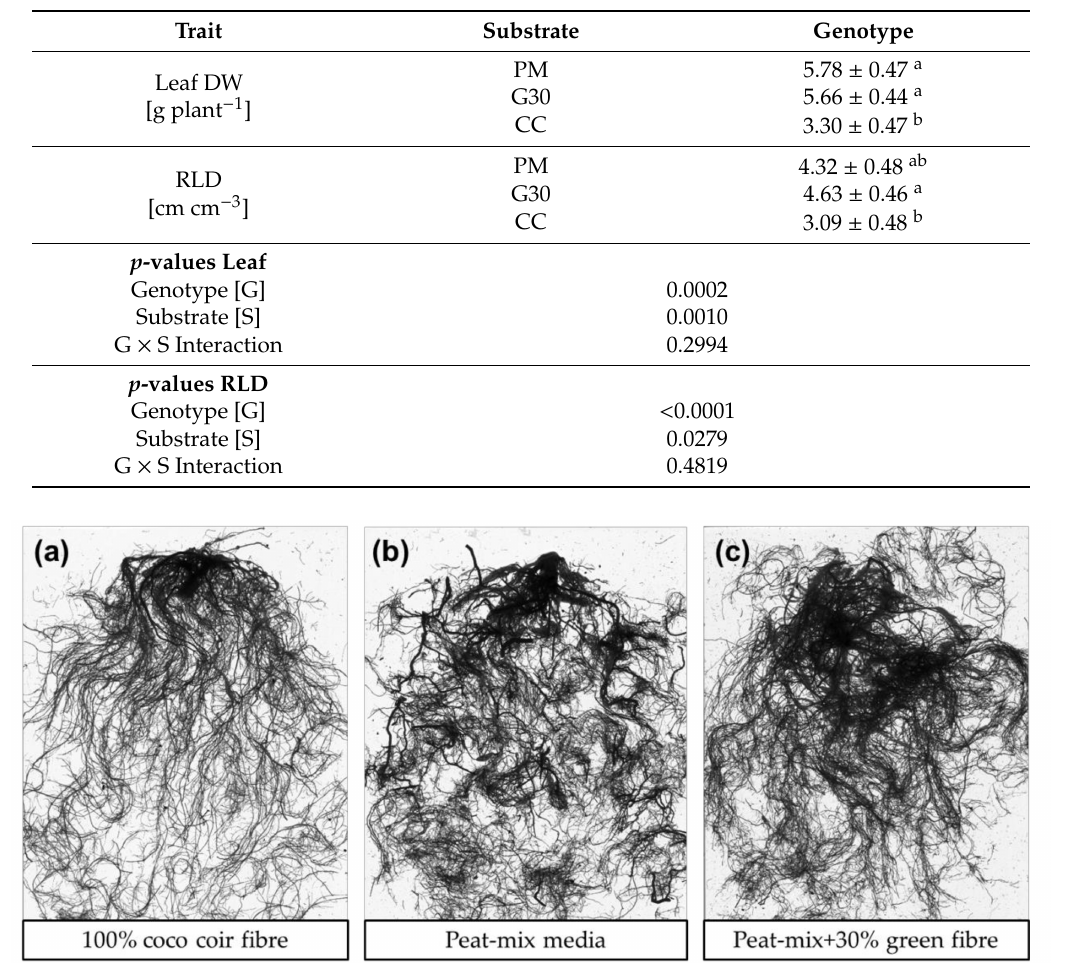
Table 4. Mean leaf dry weight (DW) in g plant − 1 and root length density (RLD) in cm cm − 3 of genotypes KAN and 0.2x, grown on peat-mix (PM), peat-mix + 30% green fibre (G30) and 100% coco coir fibre (CC) substrate. Results are presented as mean values ± standard error (Mean ± SE). Letters compare the mean DW yield of leaves and mean RLD. Means in one column followed by at least one identical lower-case letter do not di ff er significantly as indicated by Tukey’s test ( α = 0.05). The p -values correspond to global F tests for di ff erences between the levels of the mentioned genotypes or substrates.